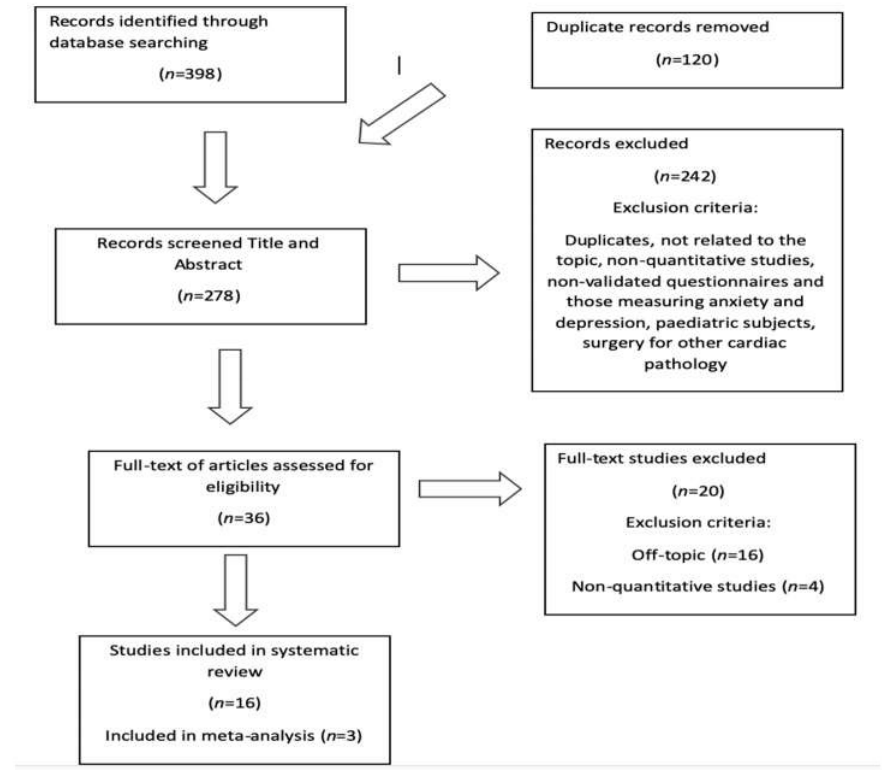
Figure 1. Study-selection diagram.